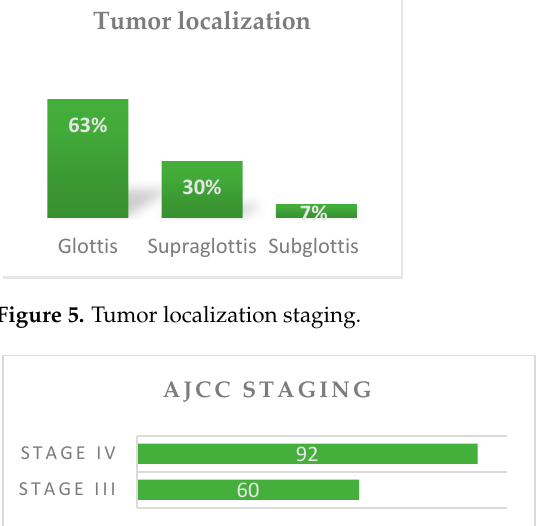
Figure 6. Tumor classification according to AJCC staging.